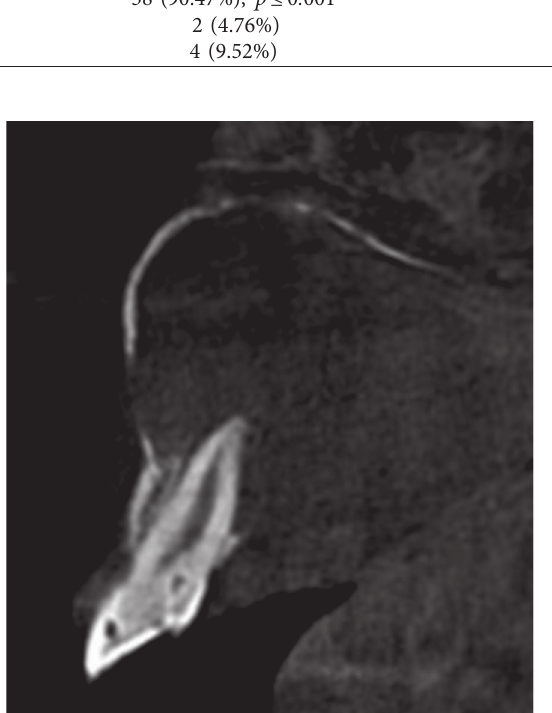
Figure 3: The right maxillary lateral incisor is a type II DI associated with an apical periodontitis PAI index 5E ″ cross-sectional image.